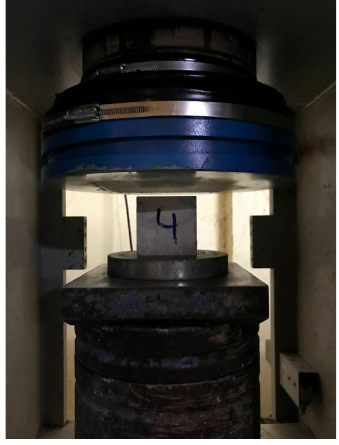
Figure 2. Mortar compression